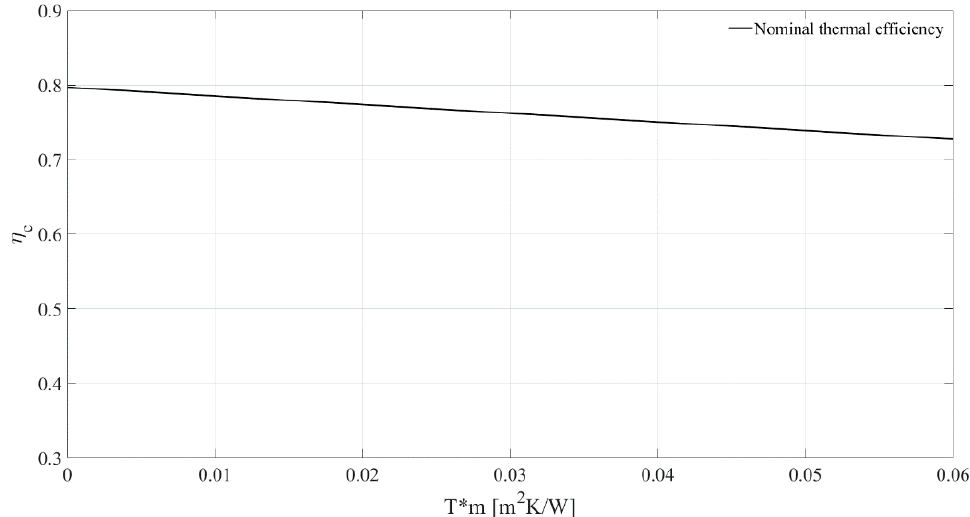
Figure 6. Thermal efficiency characteristic of the the nominal collector.